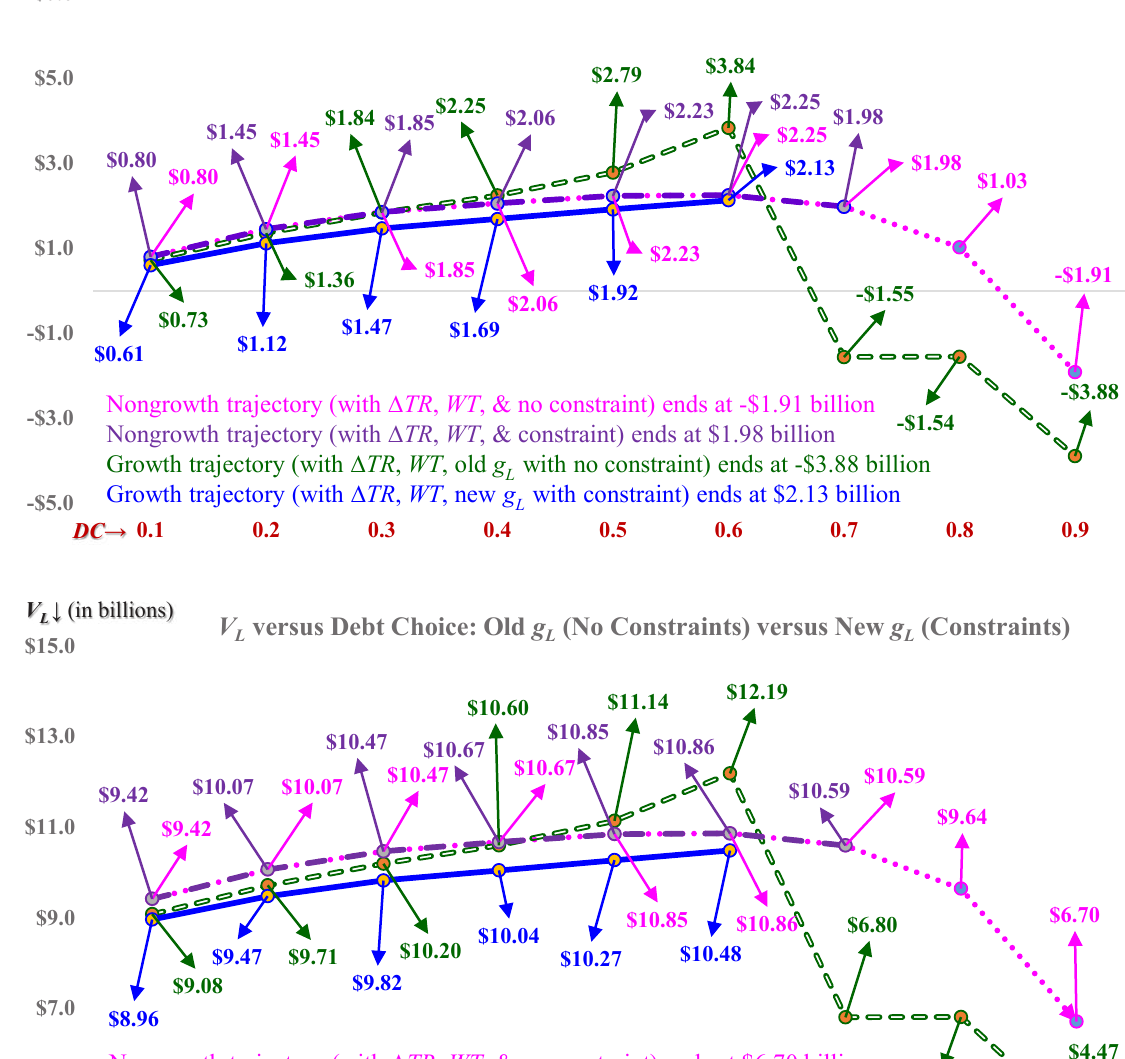
Nongrowth trajectory (with ∆ TR , WT , & no constraint) ends at $6.70 billion Nongrowth trajectory (with ∆ TR , WT , & constraint ends) at $10.59 billion Growth trajectory (with ∆ TR , WT , old g Growth trajectory (with ∆ TR , WT , new g DC →